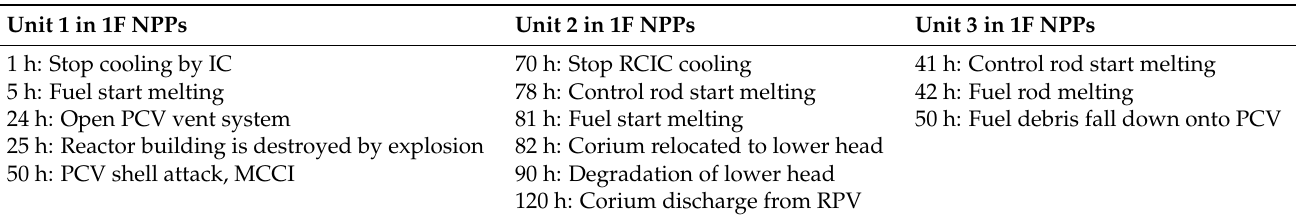
Table 1. Summary of accident scenarios in 1FNPPs